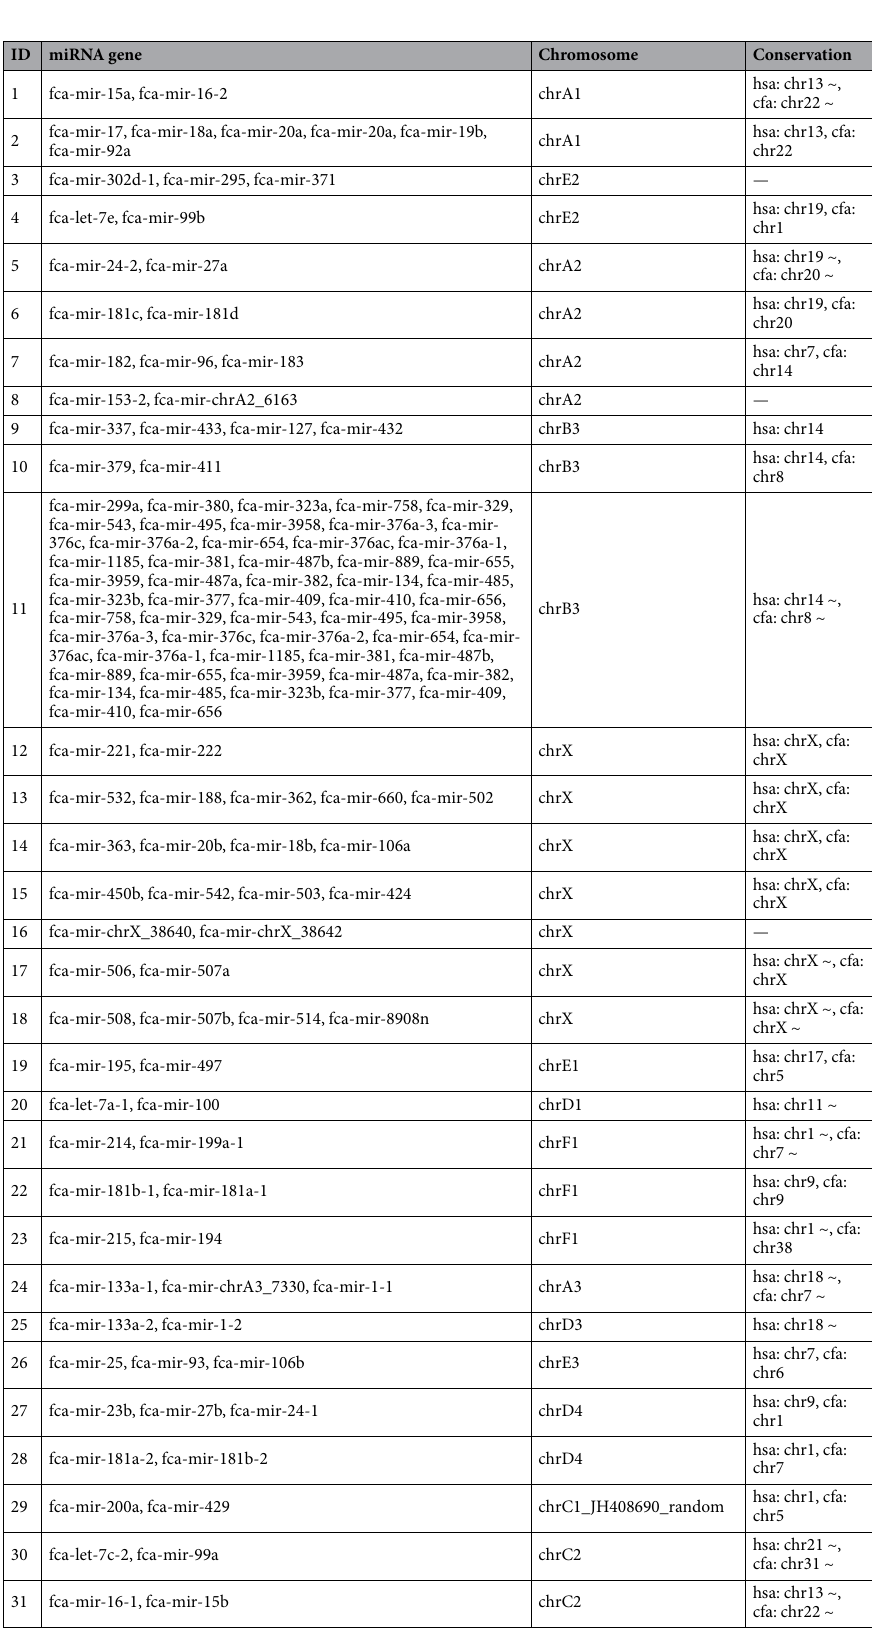
Table 2. miRNA clusters identified by our